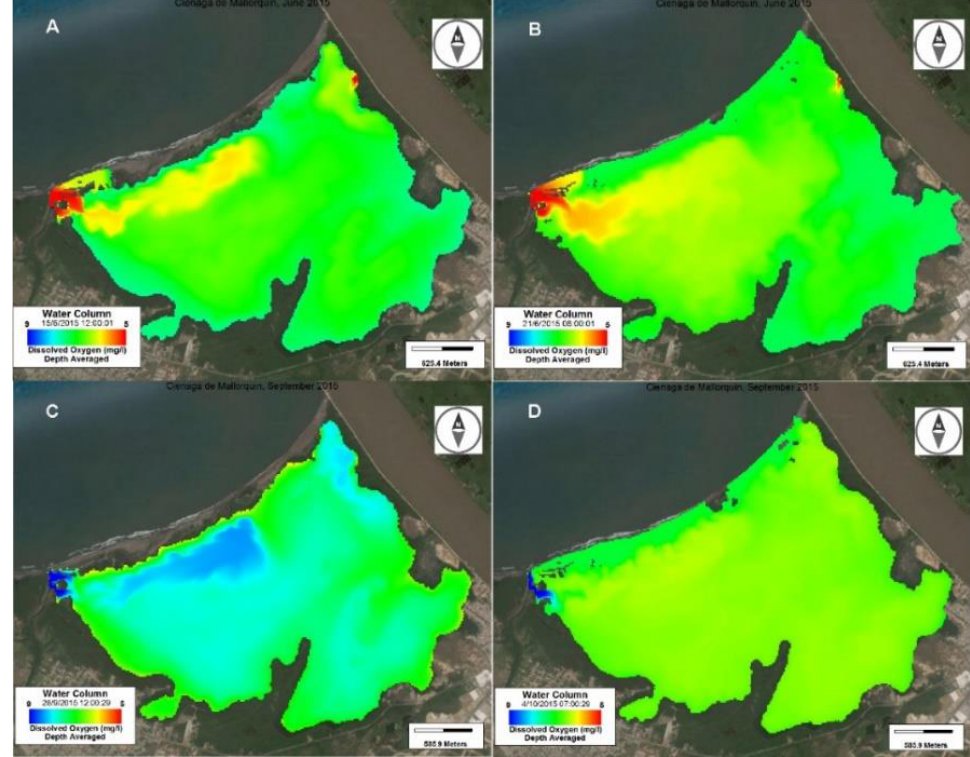
Fig. 6: Simulation of DO variation. A) Transition Period (0.5 days of simulation). B) Transition Period (6 days of simulation). C) Wet season (0.5 days of simulation). D) Wet season (6 days of simulation) (wet season: note the change in scale